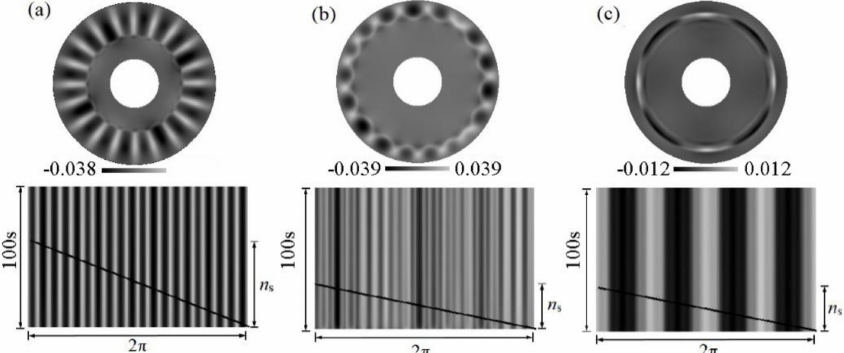
Figure 7. Evolution of surface oscillation patterns ( top ) and the corresponding STD ( bottom ). ( a ) Re T =